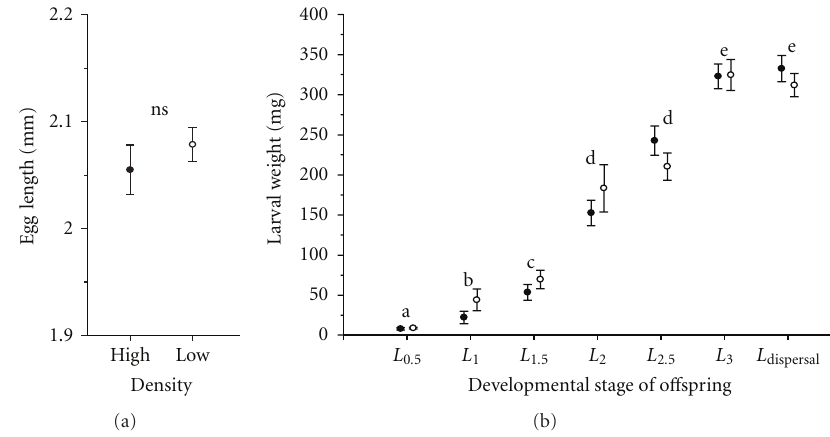
Figure 3: Egg size (measured as egg length) (a) and larval weight in relation to developmental stage of o ff spring (i.e., larval age) (b) for high (filled circles) and low-density females (open circles). L 0 . 5 , L 1 , L 1 . 5 , L 2 , L 2 . 5 , and L 3 : oldest larvae were 0.5, 1, 1.5, 2, 2.5, or 3 days old; L dispersal : larvae had left the brood cavity and were dispersing. Di ff erent letters indicate di ff erence at P < 0 . 05 between developmental stages for both female densities combined. Means and SE are